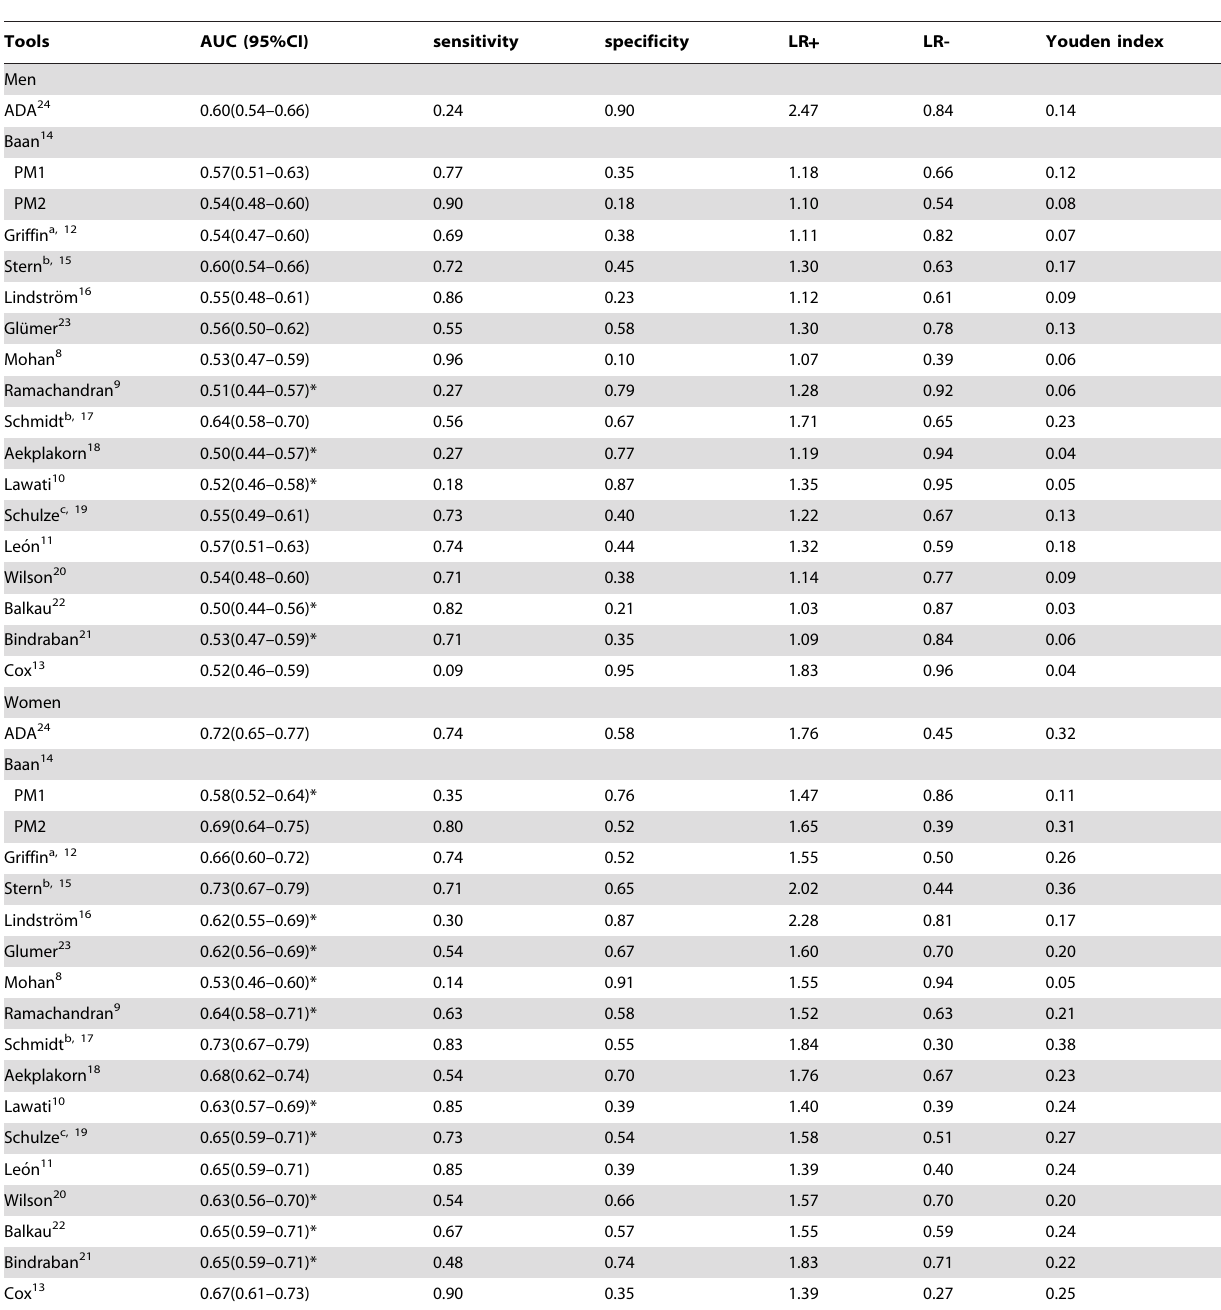
Table 4. ADART and instruments published in literature in screening undiagnosed pre-diabetes and diabetes.